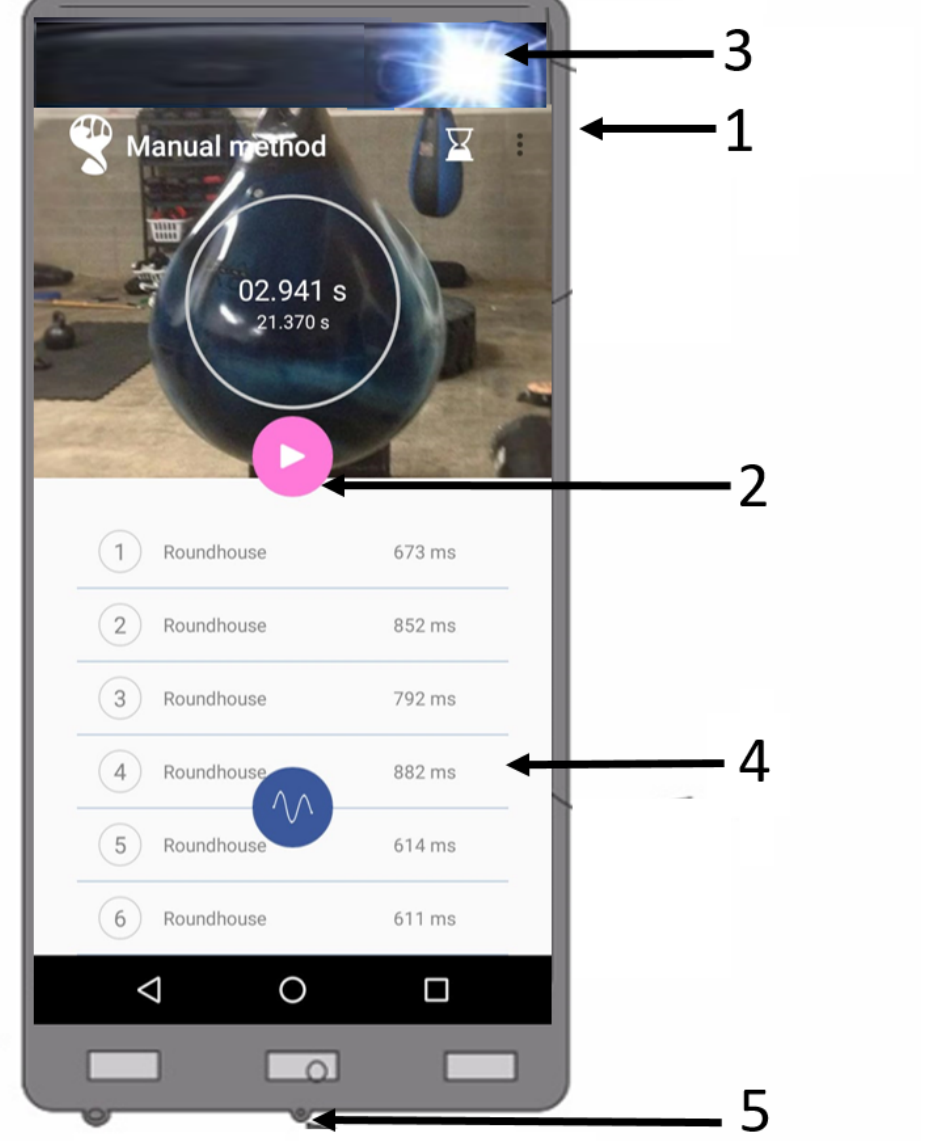
Figure 1. Representation of the TReaction app system. See text above for explanation of numbered